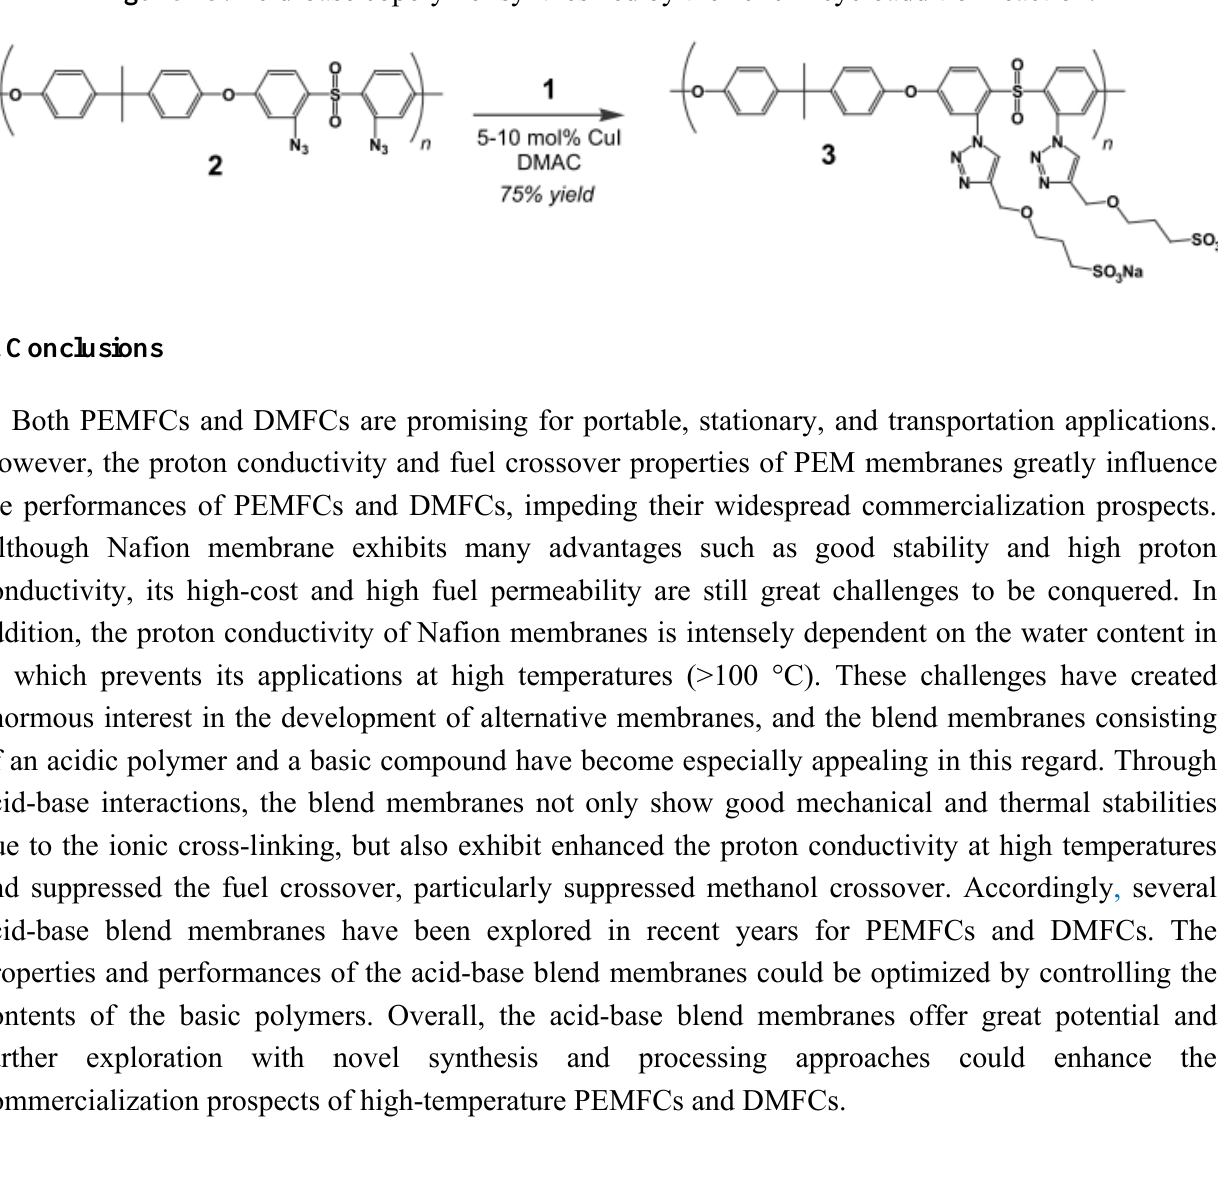
Figure 13. Acid-base copolymer synthesized by the “click” cycloaddition